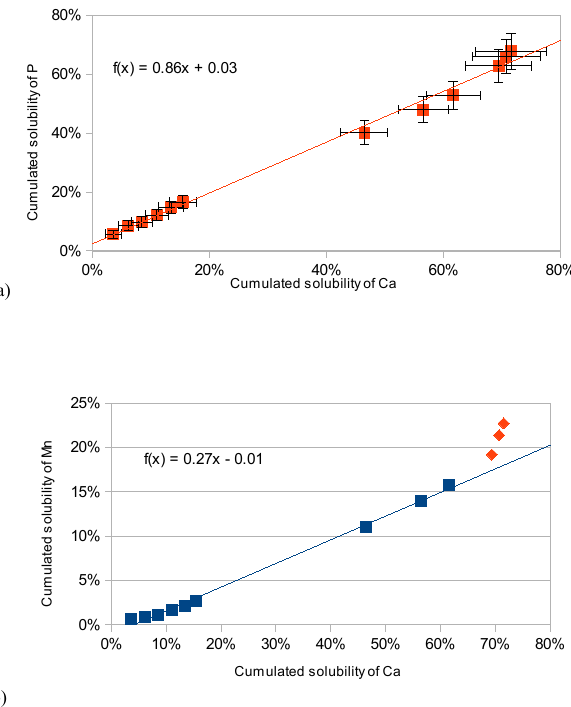
Figure 2. Cumulated solubility of P (A) and Mn (B) as a function of the cumulated solubility of Ca. The plotted line is a least-squares linear regression. The three orange points for Mn are not included in the regression and were obtained at pH 1.